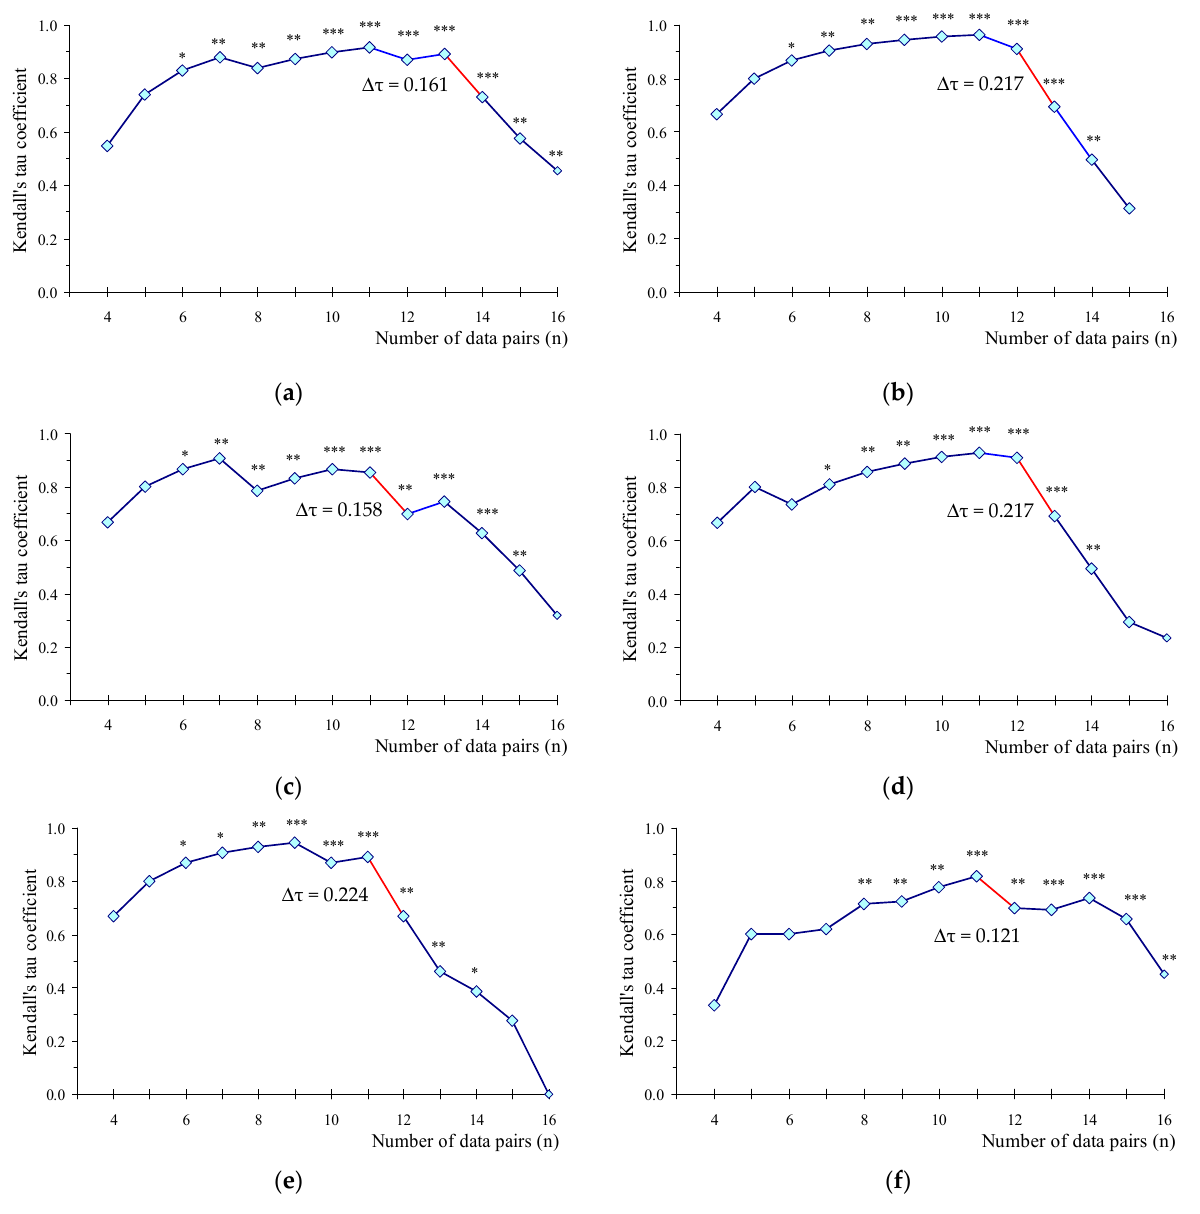
Figure 5. Changes in the value of the Kendall coefficient ( τ ) for the series of n data pairs ( n = 4 to 16) of the number of fish caught using Nordic multimesh gillnets ( N E ) in TL E classes determined based on various TS – TL relationships and the corresponding number of fish determined hydroacoustically ( N H ). The change in the value of the Kendall coefficient ( Δ τ ) is marked in red, indicating the incompatibility of pairs within the observed data. ( a ) Equation (1), ( b ) Equation (2), ( c ) Equation (3), ( d ) Equation (4), ( e ) Equation (5), and ( f ) Equation (6); *— p < 0.1; **— p < 0.05; ***— p < 0.01. The best fit was obtained for the linear model built on the basis of Equation (4) ( r 2 = 0.91). Among the TS – TL relations, the use of which allowed a slope close to unity to be obtained, the highest accuracy of the estimation of the percentage of fish caught based on acoustic data was provided by Equations (2) ( r 2 = 0.90) and (5) ( r 2 =